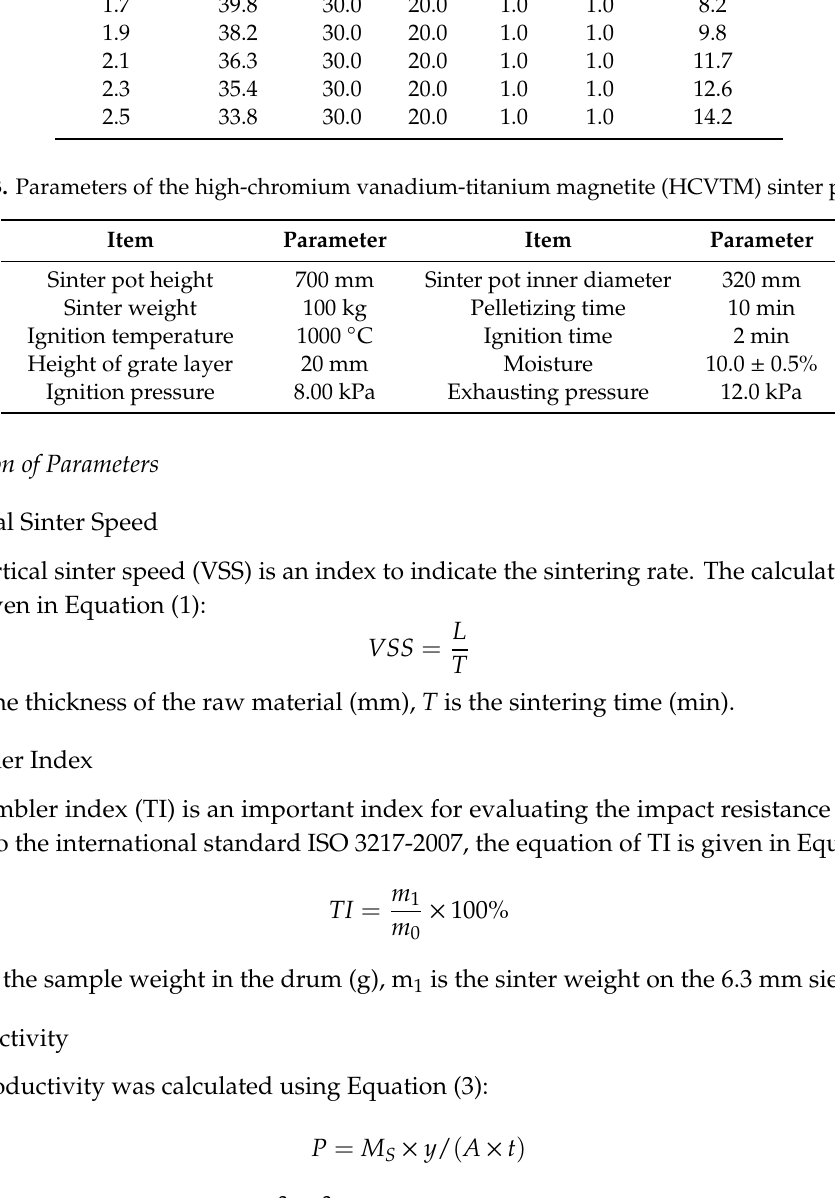
Table 2. Experimental scheme and ingredients of sinter materials (wt%). Basicity